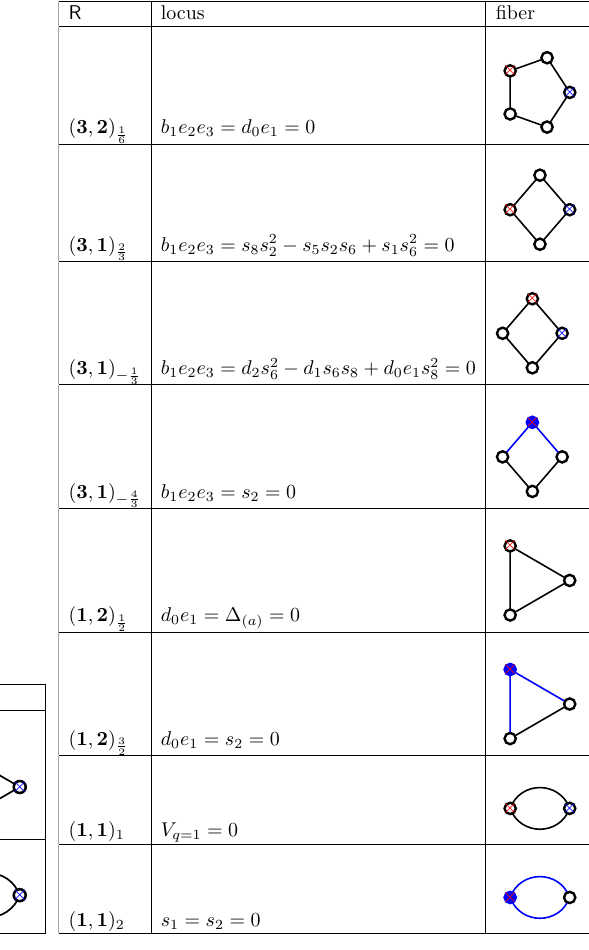
Table 1 . Singular elliptic fibers of the resolution X 5 → X 0 (see eq. (3.10)) of the (SU(3) × SU(2) × U(1)) / Z model over codimension-one and codimension-two components of the discriminant locus 6 ∆ = 0 ; these singular fibers correspond to (resp.) gauge symmetries and charged matter represen- tations. The nodes of the graphs in the right-most columns represent irreducible components of the singular elliptic fibers, while the edges of the graphs correspond to points of intersection between pairs of irreducible components. Each irreducible component is birational to P 1 . A blue (red) ‘ × ’ in the center of a node indicates that the curve represented by that node intersects the zero section (generating section) at a point away from the points of intersection with other P 1 components. A blue node is an exceptional P 1 wrapped by the zero section; such curves correspond in the M-theory frame to primitive BPS particles whose KK central charges are approximately the same scale as their Coulomb branch central charges. (Note that we express the loci in terms of the parameters of the resolution X , so that d = 0 , b = 0 are, respectively, the SU(2) , SU(3) gauge divisors 5 0 e 1 1 e 2 e 3 Σ Σ 2 , 3 ⊂ B